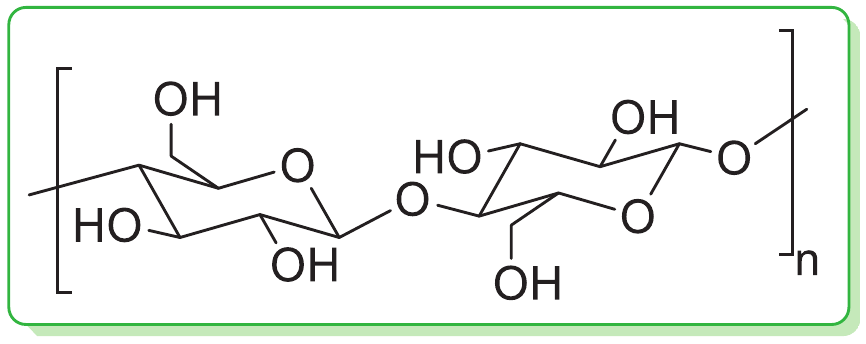
Figure 1. Chemical structure of cellulose.